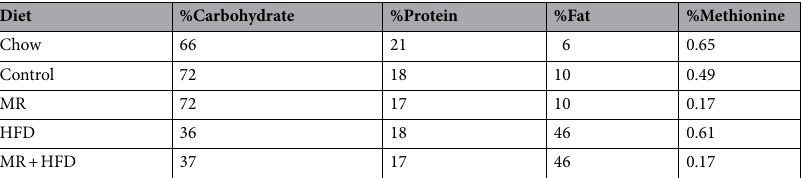
Table 2. Diet composition of chow and experimental diets fed to mice for the duration of the study. Nutrients are expressed as percentages of total calories (kCal). MR methionine restricted diet, HFD high fat